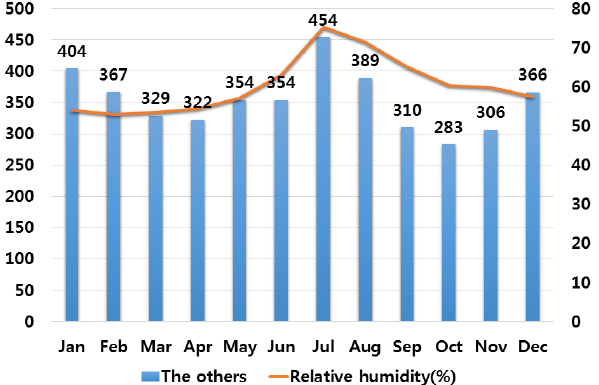
Figure 9. Correlation between the number of fires caused by partial disconnection and the average humidity on a monthly basis.